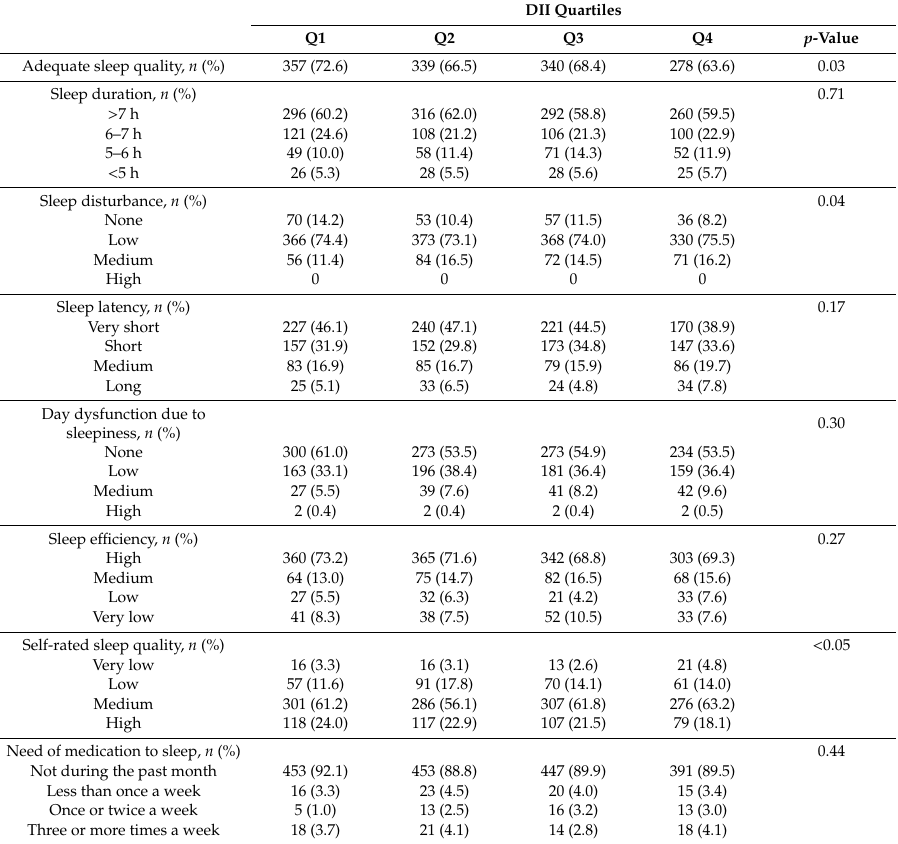
Table 2. Overall sleep quality and sleep-related characteristics of the study participants by quartiles of Dietary Inflammatory Index (DII).